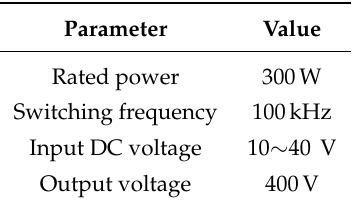
Figure 7. The 300-W prototype of the SICIBB converter. Table 4. Design specifications.